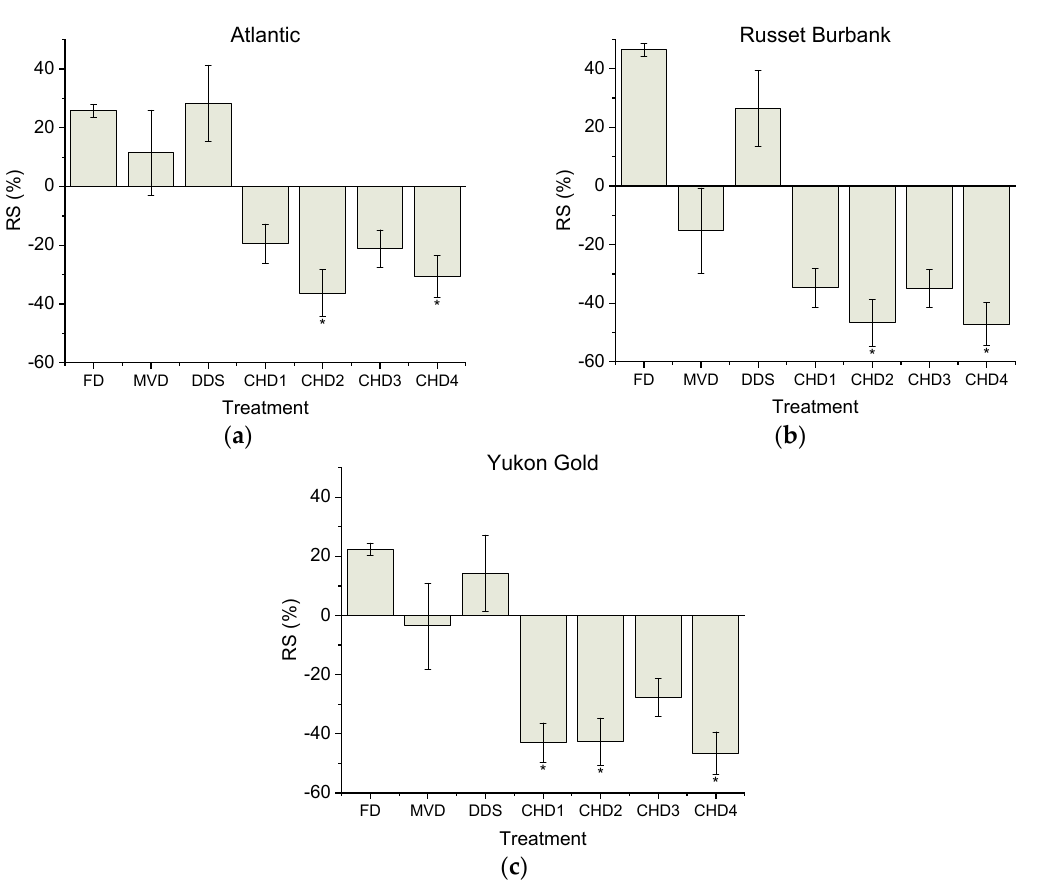
Figure 2. Resistant starch (percent difference) compared to fresh controls for Atlantic ( a ), Russet Burbank ( b ) and Yukon Gold ( c ) potato cultivars. Baseline RS content of freshly cooked controls were 6.20 ± 0.44, 5.98 ± 0.45 and 6.91 ± 0.23 (g/100 g DW) for ALT, RB and YG respectively. Different drying treatments were assessed and compared to a fresh control using Dunnett’s test. Data is presented as mean ± SEM. For each genotype, * indicates statistically significant ( p < 0.05) difference in comparison to control (fresh).